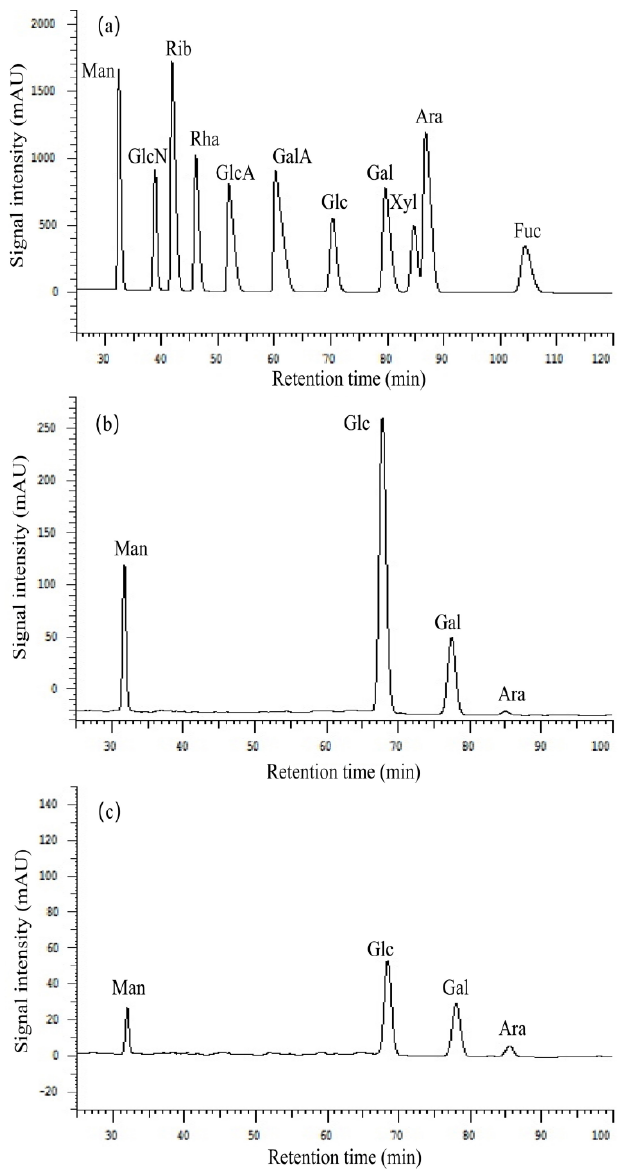
Figure 4. High performance liquid chromatogram of monosaccharide composition of standard monosaccharide ( a ), AcRDP-1 ( b ), and AcRDP-2 ( c ). (Man, mannose; GlcN, glucosamine; Rib, ribose; Rha, rhamnose; GlcA, glucuronicacid; GalA, galacturonicacid; Glc, glucose; Gal, galactose; Xyl, xylose; Ara, arabinose; Fuc, fucose).